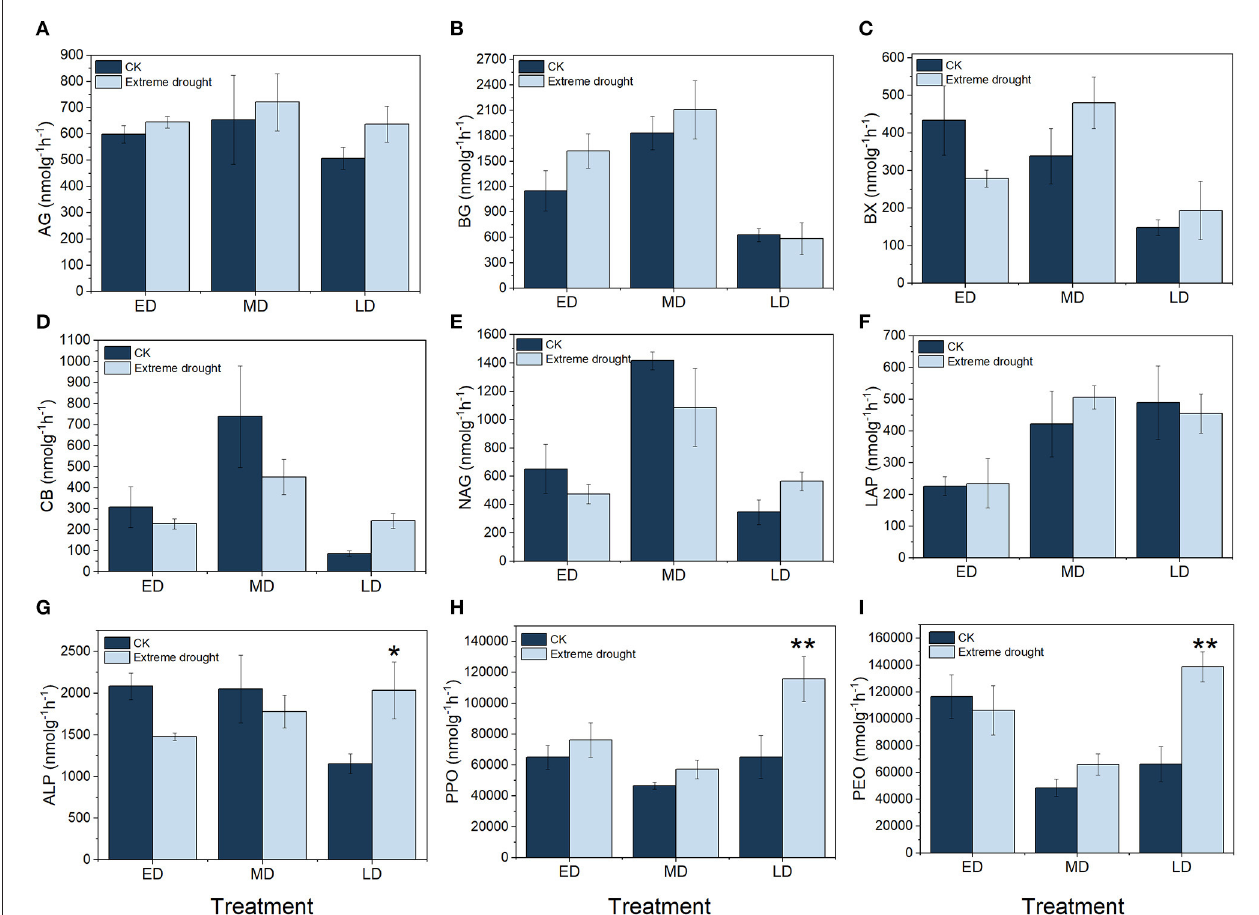
FIGURE 3 | Soil enzyme activities of C-acquisition (A–D,H,I) , N-acquisition (E,F) and P-acquisition (G) resulting from different treatments. ED, early drought; MD, midterm drought; LD, late drought; CK, the ambient control treatment corresponding to each stage of extreme drought treatment. AG, α -1,4-glucosidase; BG, β -1,4-glucosidase; BX, β -1,4-xylosidase; CB, cellobiosidase; NAG, β -1,4-N-acetyl-glucosaminidase; LAP, leucine amino peptidase; ALP, alkaline phosphatase; PPO, polyphenol oxidase; PEO, peroxidase; **, p < 0.01; *, p < 0.05. Relevant data are indicated by the mean ± standard error ( n = 3; bars indicate